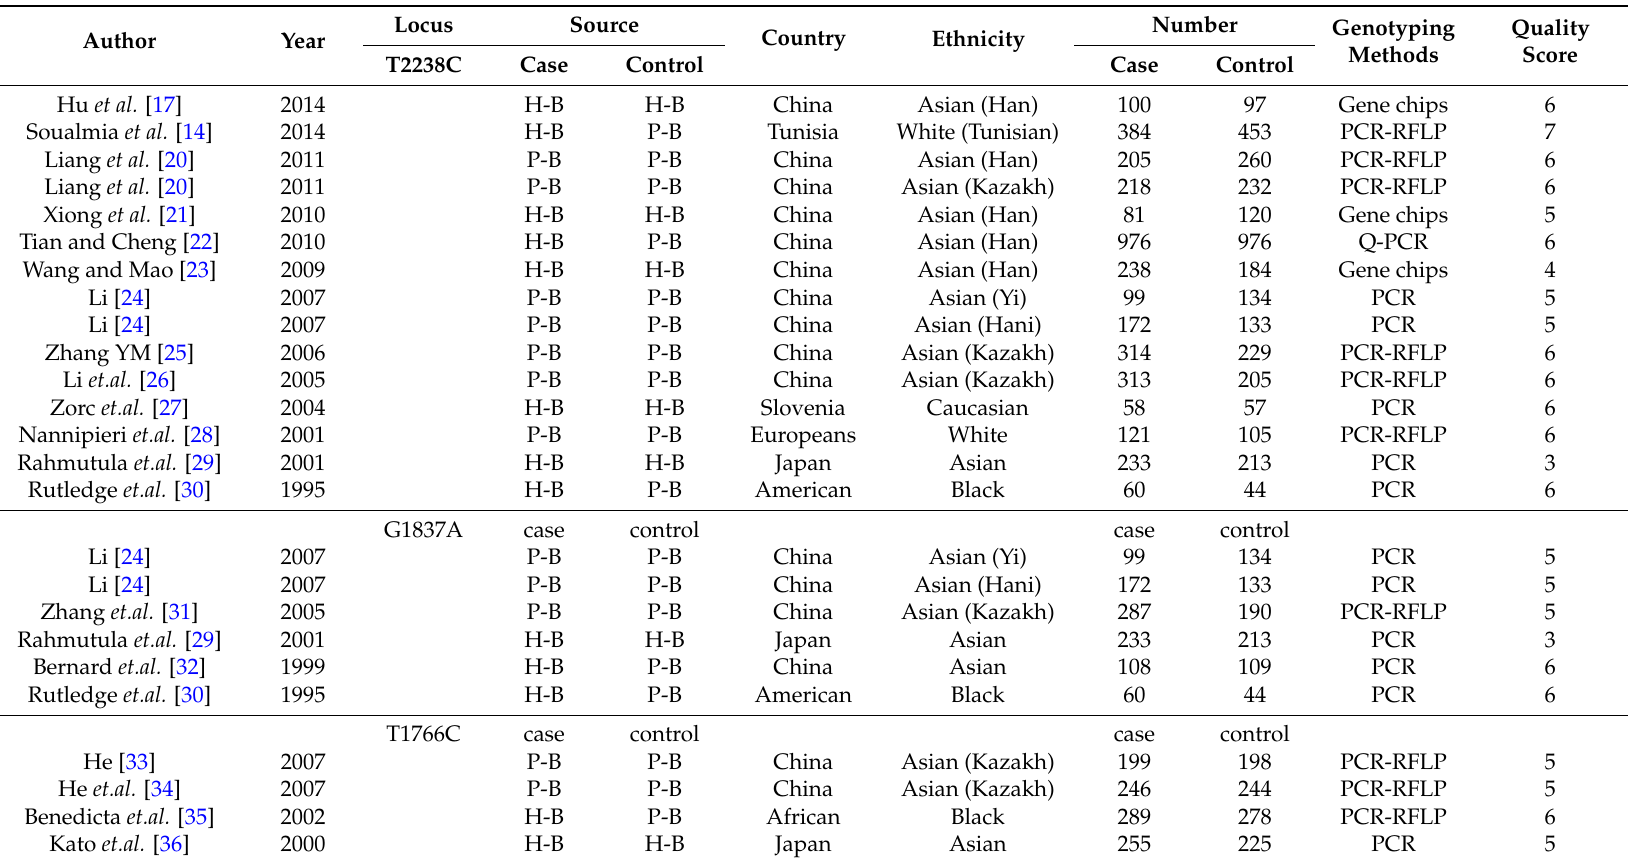
Table 1. Characteristics of studies included in the